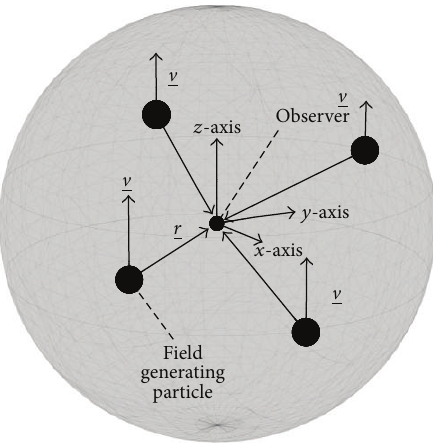
Figure 3: When the observer moves, the universe appears to instan- taneously countermove.